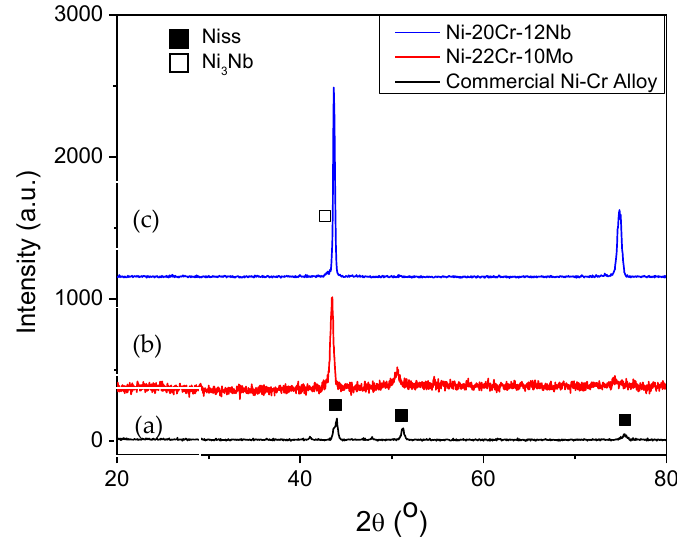
Figure 1. XRD patterns of Ni-Cr alloys evaluated in this work: ( a ) Commercial Ni-Cr alloy, ( b ) Ni-22Cr-10Mo alloy and ( c ) Ni-20Cr-12Nb alloy.